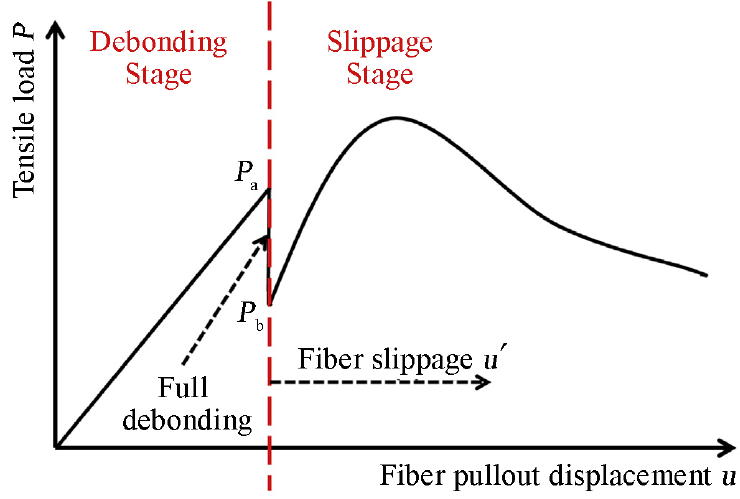
Figure 15. Illustration of typical single-fiber pullout force-displacement curve.